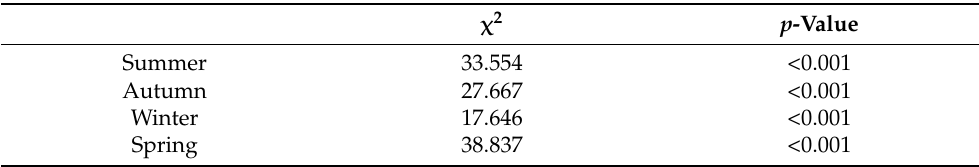
Table 4. Results obtained between the clothing insulation level of male and female students for each season.